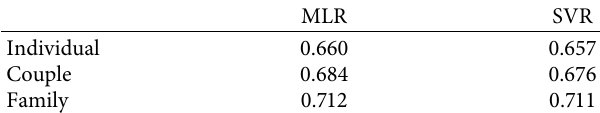
Figure 4: Scatter plot illustrating the overall score as a function of Elementary scores for the three categories of customers. Table 1: Accuracy of MLR and SVR